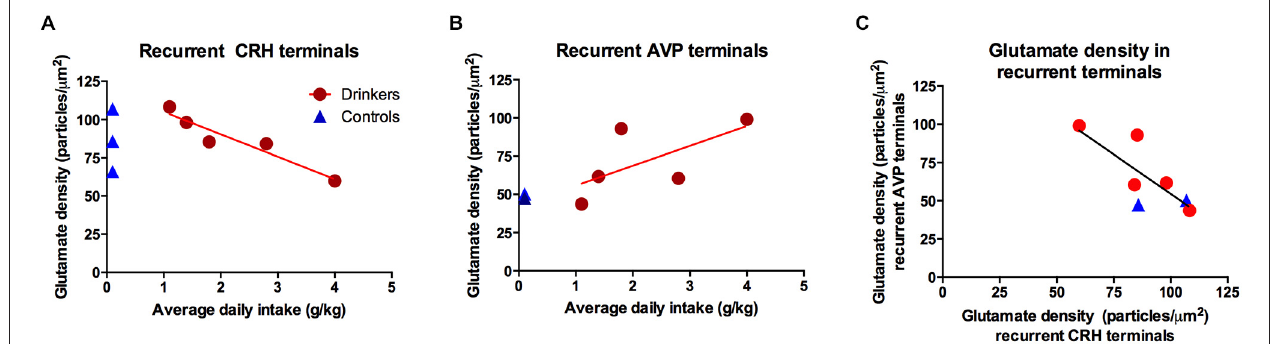
terminals did not correlate with average daily ethanol intake ( R 2 = 0.65, p = 0.23), a weak trend towards an increase in animals consuming ethanol as seen in the inset ( p = 0.10). (C) Glutamate density in CRH and AVP recurrent terminals were correlated ( R 2 = − 0.78, p = 0.04). Blue triangles: controls; red circles: drinkers.